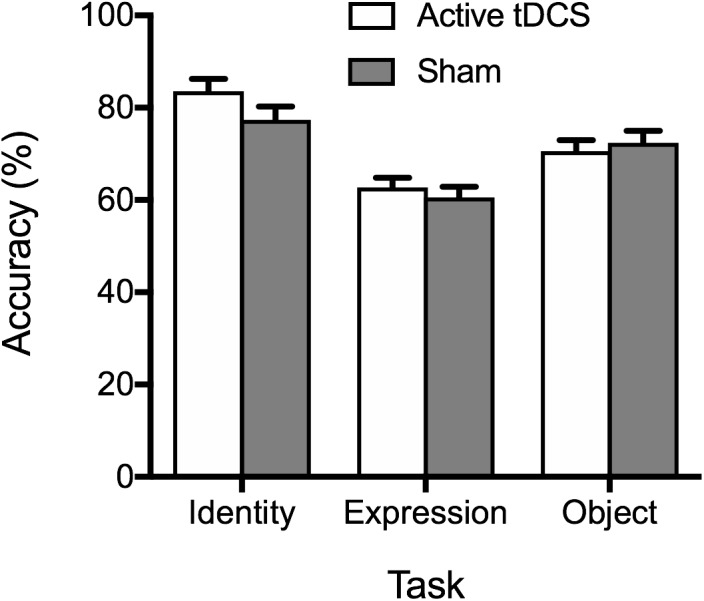
Mean percentage accuracy on the identity, expression, and object tasks for the active tDCS and sham groups. Standard error bars are displayed in this and all subsequent figures.